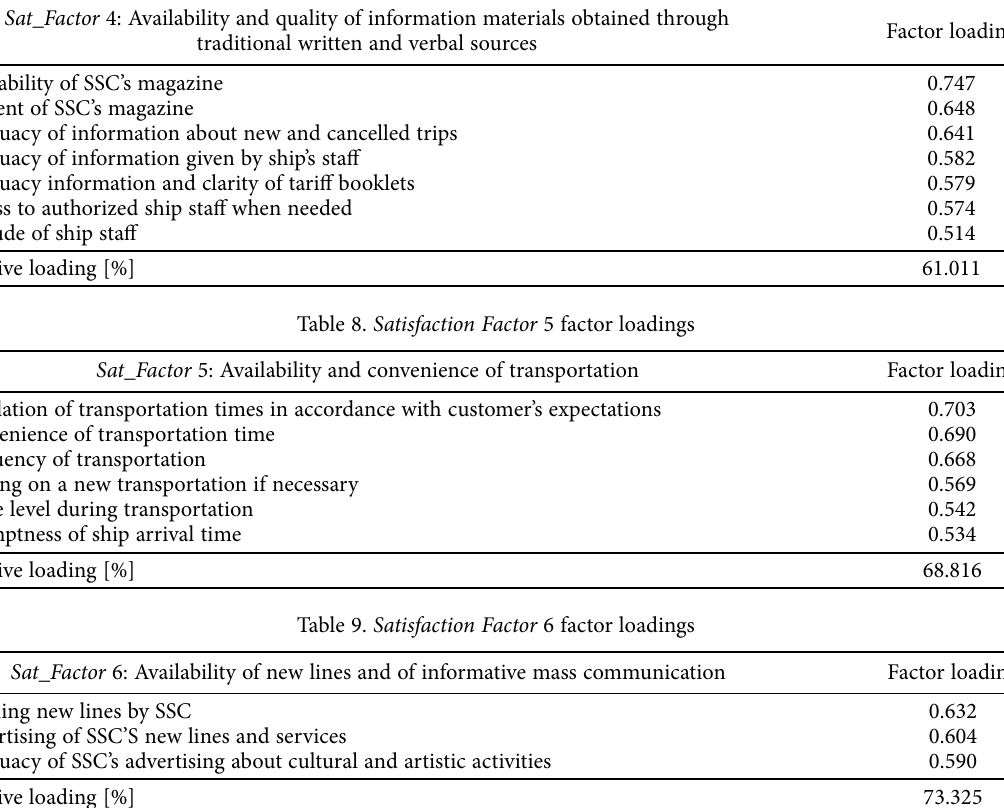
Table 7. Satisfaction Factor 4 factor loadings